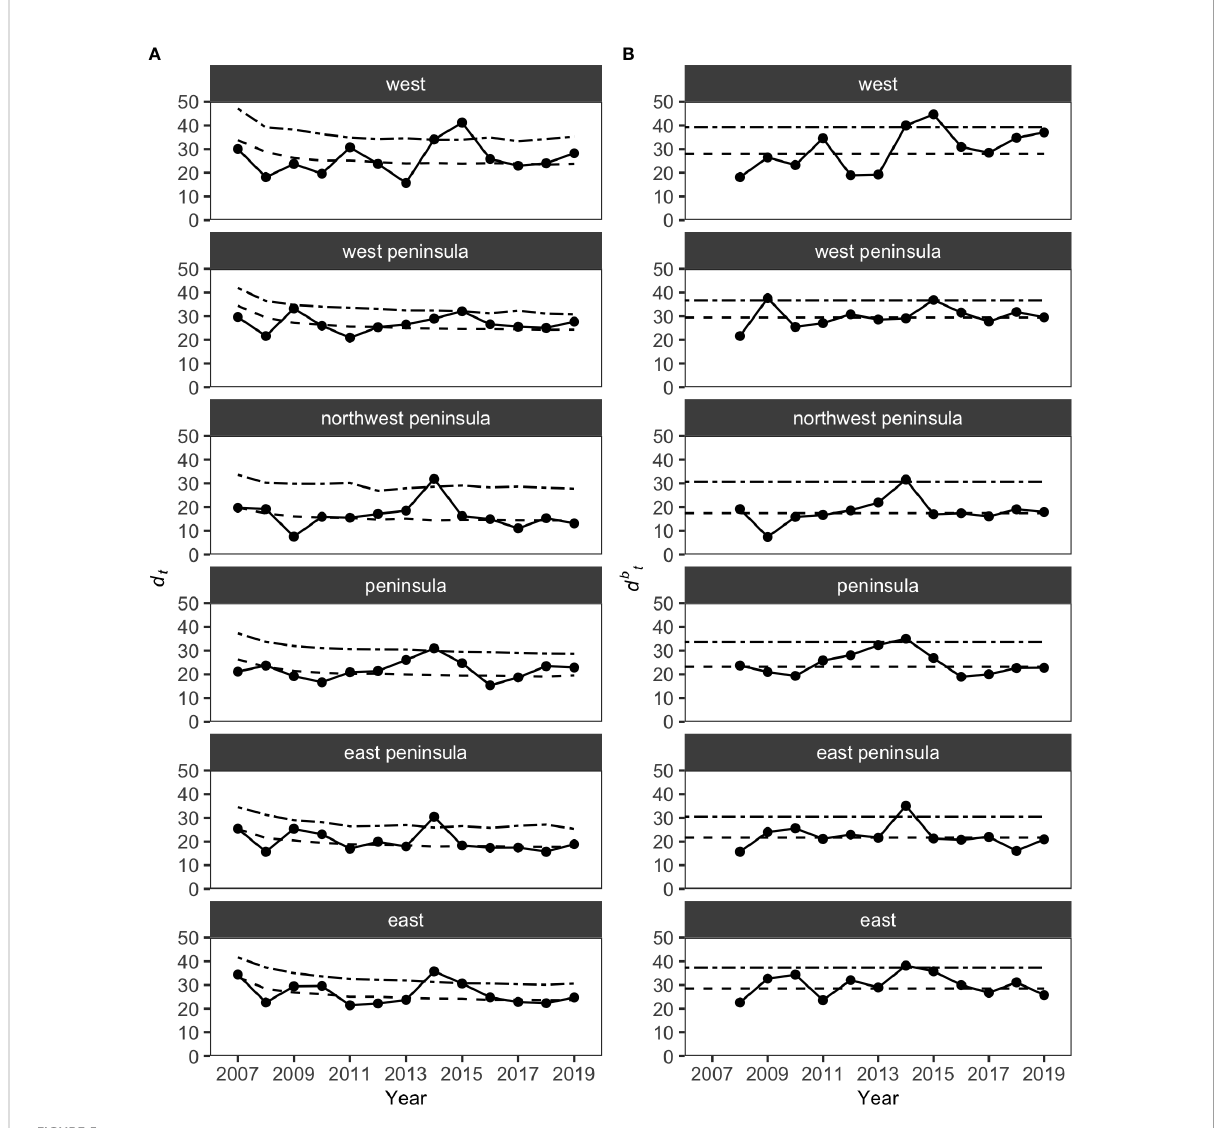
FIGURE 5 Results of MCCs for KALA fi sh assemblages showing (A) d t values and (B) d b t values. Dashed lines on each plot show 50 percentile con fi dence bounds as representations of the temporal trends, and dash-dotted lines show 95 percentile con fi dence bounds as upper con fi dence limits under which the status of the regions were considered stable or within natural